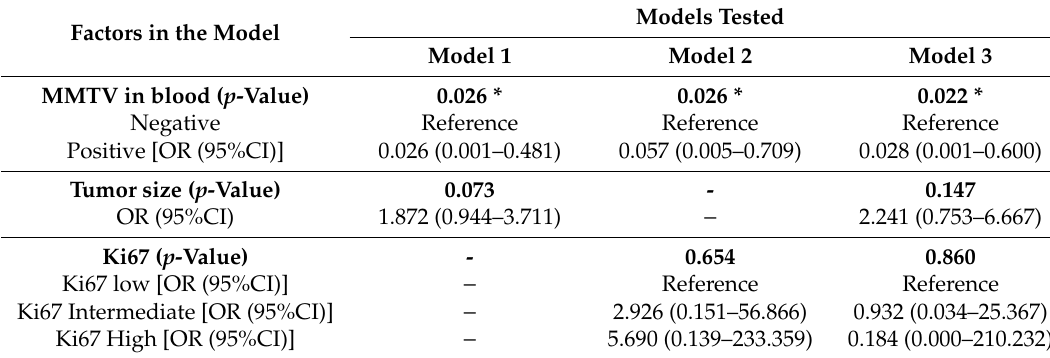
Table 5. AssociationbetweenMMTV- env inbloodandLNmetastasisadjustingforotherclinicopathological features in luminal A breast